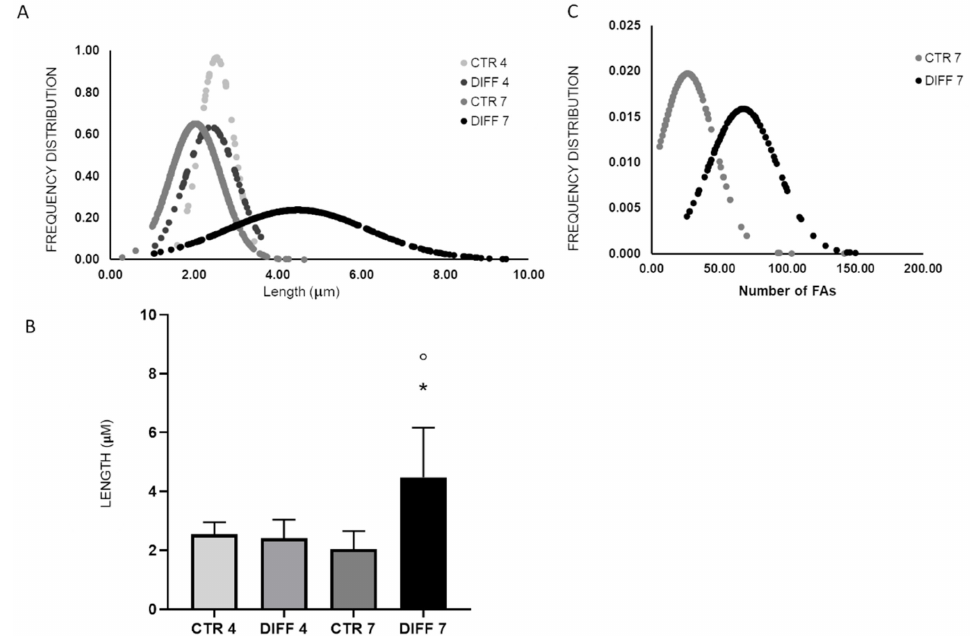
Figure 6. Morphometric analysis length ( A , B ) and number per cell ( C ) of H9c2 focal adhesions grown for 4 and 7 days in control and differentiation medium. Data are expressed as Gaussian curves with n ≥ 100. Measures were taken from representative fluorescence microscopy images (100 × magnification). Statistical significance with respect to the relative controls (* p ≤ 0.05); statistical significance with respect to differentiated cells at day 4 ( ◦ p ≤